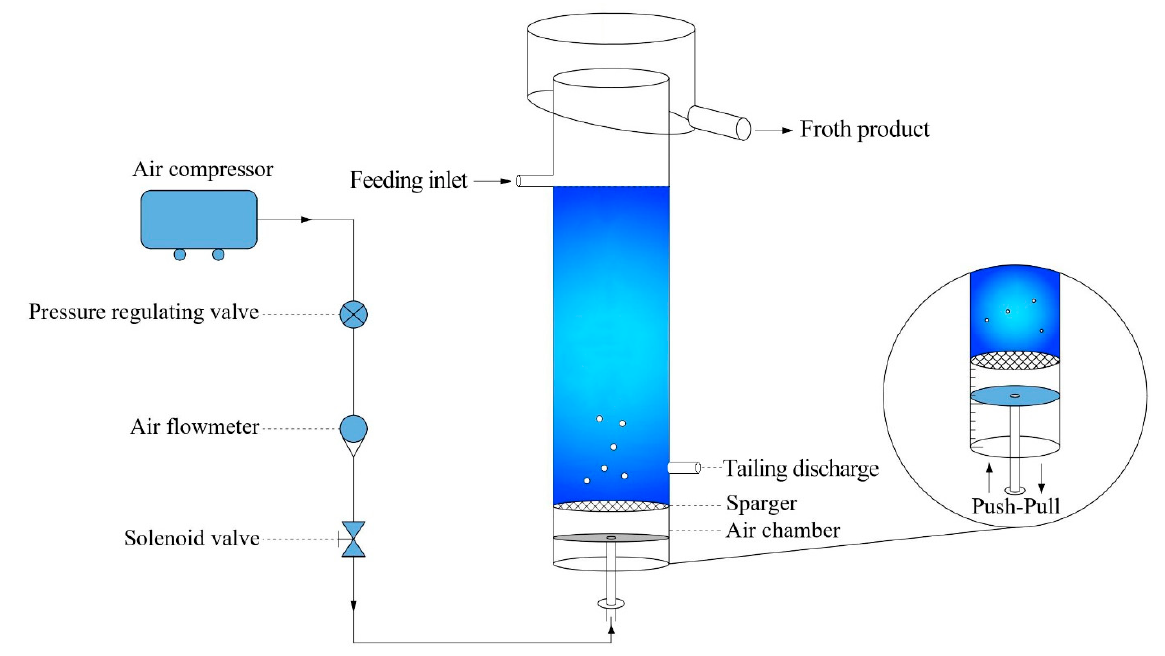
Figure 1. Schematic of the flotation set-up with oscillatory air supply. A solenoid valve (Festo, Shanghai, China) was used to change the flow pattern of air supply from steady to oscillatory. The features that can be adjusted included the switching frequency and the on/off time ratio within every switching cycle. The pressure and gas flow rate passing through the solenoid valve were controlled using an air pressure regulator and air flow meter, respectively. A laser probe (A2 Photonic Sensors, Grenoble, France) was used to measure bubble size in situ. The probe is made of an optical fiber with a micromachined tip. It operates by contact and measures all bubbles that get pierced by